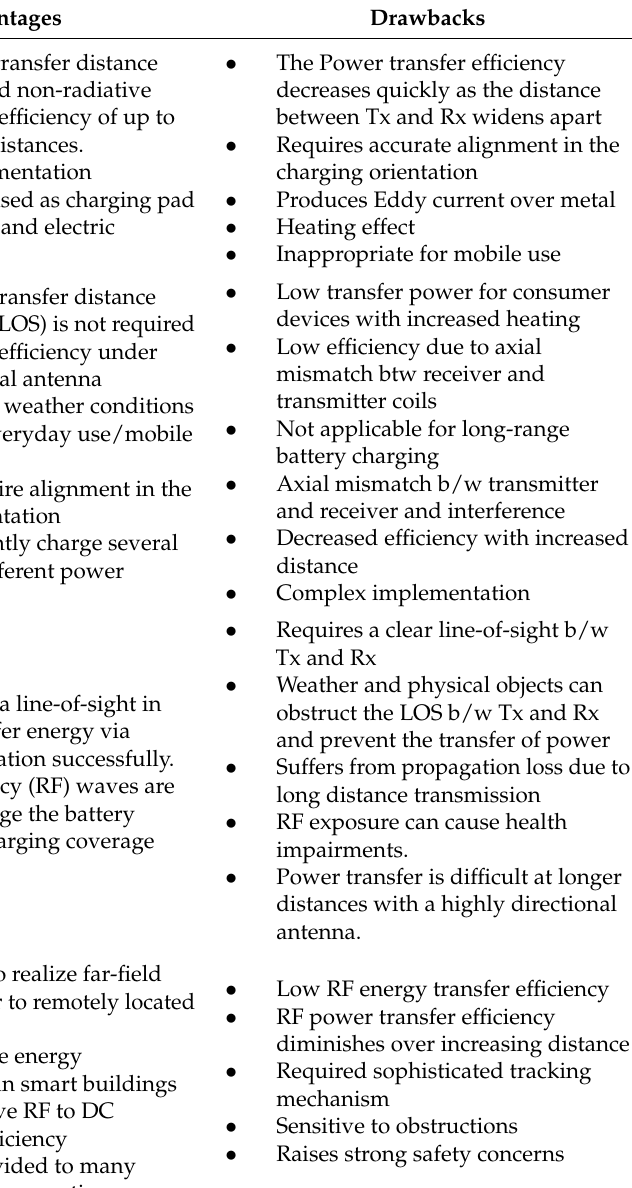
Table 1. A comparative summary of WPT technologies for IoT scenarios.